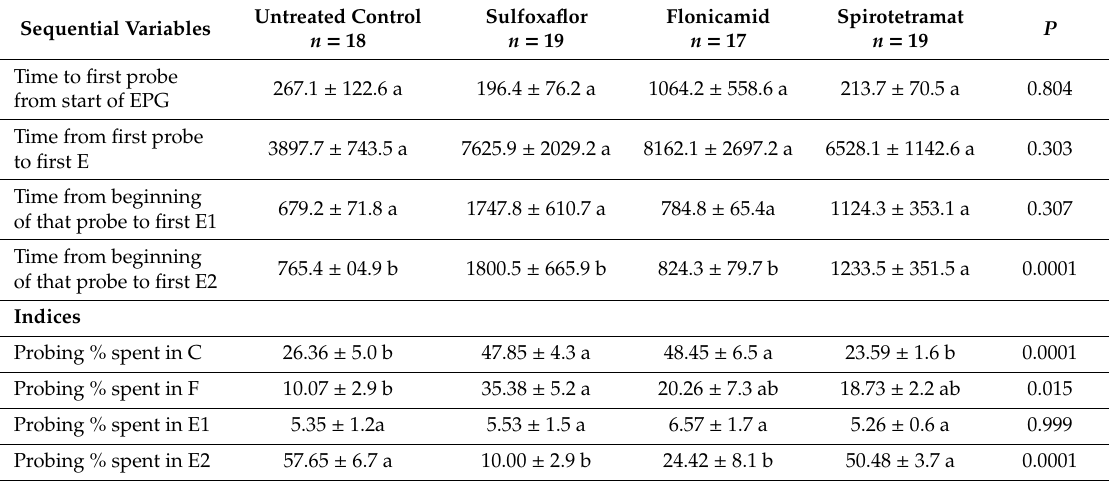
Table 2. EPG variables of probing and feeding behavior of Myzus persicae adults exposed to insecticide-treated and untreated plants. Values represent mean ± standard error values of sequential variables, and percentage of probing time spent in a specific waveform (time expressed in